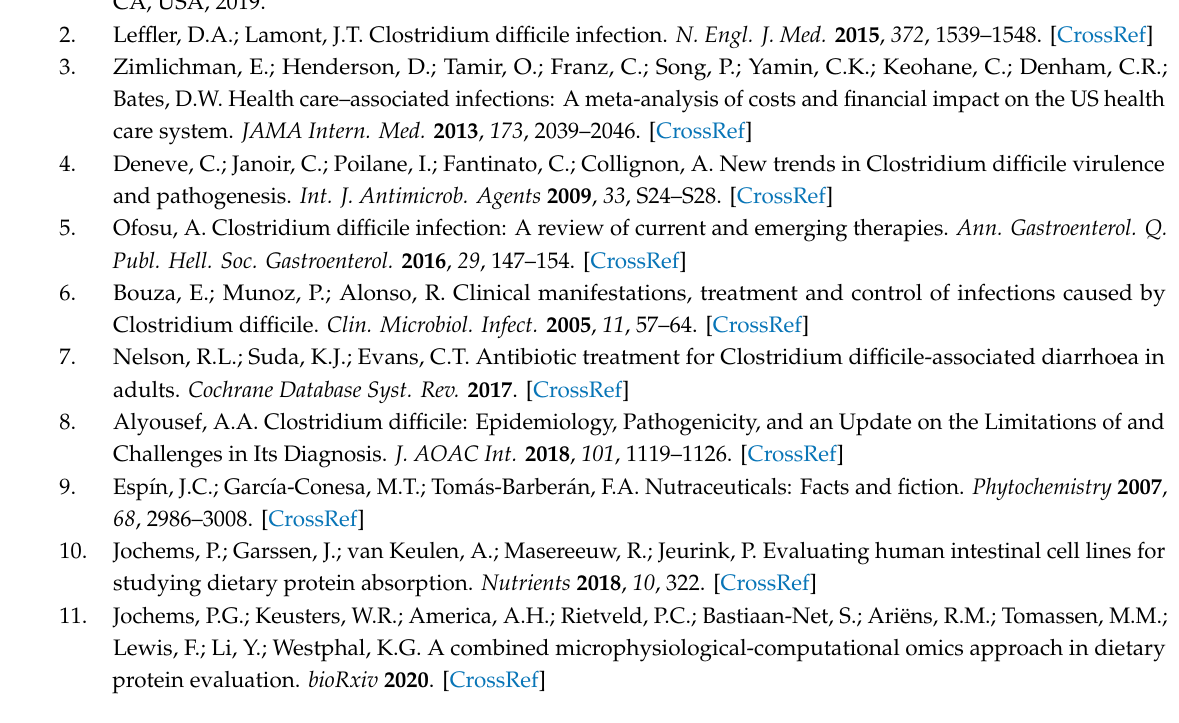
Figure S1: Pilot study in Transwell TM inserts show no protective e ff ect against TcdA-induced epithelial